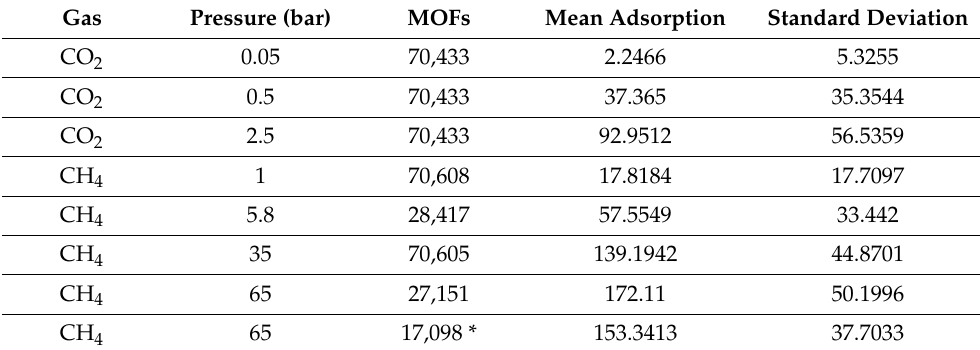
Table 1. Datasets